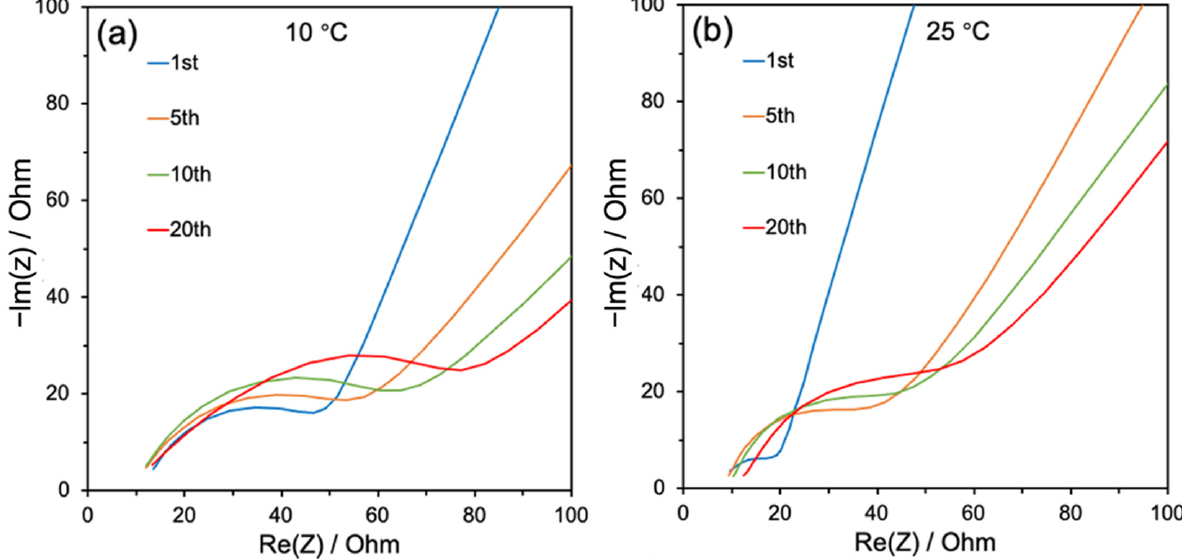
Figure 7. Nyquist plots of HC electrode after different numbers of cycles at 100 mA g − 1 ( a ) 10 °C, ( b ) 25 °C, ( c ) 40 °C and ( d ) 80 °C. In the low frequency part of the data, the Warburg impedance corresponding to so- dium ion diffusion and its diffusion coefficient ( 𝐷 (cid:3015)(cid:3028) (cid:3126) ) could be calculated with the follow- ing equation [43]: 𝐷 (cid:3404) 𝑅 (cid:2870) 𝑇 (cid:2870) 2𝐴 (cid:2870) 𝑛 (cid:2872) 𝐹 (cid:2872) 𝐶 (cid:2870) 𝜎 (cid:3024)(cid:2870)